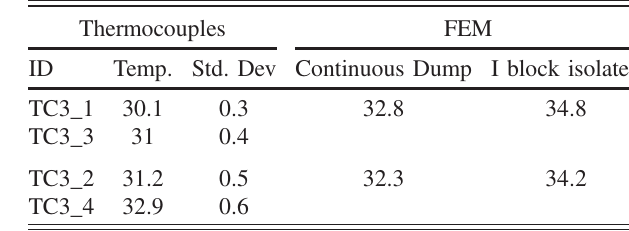
TABLE III. Average temperatures registered by the thermo- couples placed on the upstream surface of the dump core in the time period from 12:00 to 20:00 of the 11th of March 2018. An accuracy of 2 . 5 °C is expected for these sensors. Next to the measurements, the temperatures registered in the corresponding points of the two FEM models that were considered. Since the FEM models are symmetric with respect to the vertical plane, only one FEM result corresponds to each couple of thermocouple measurements. Temperatures are reported in